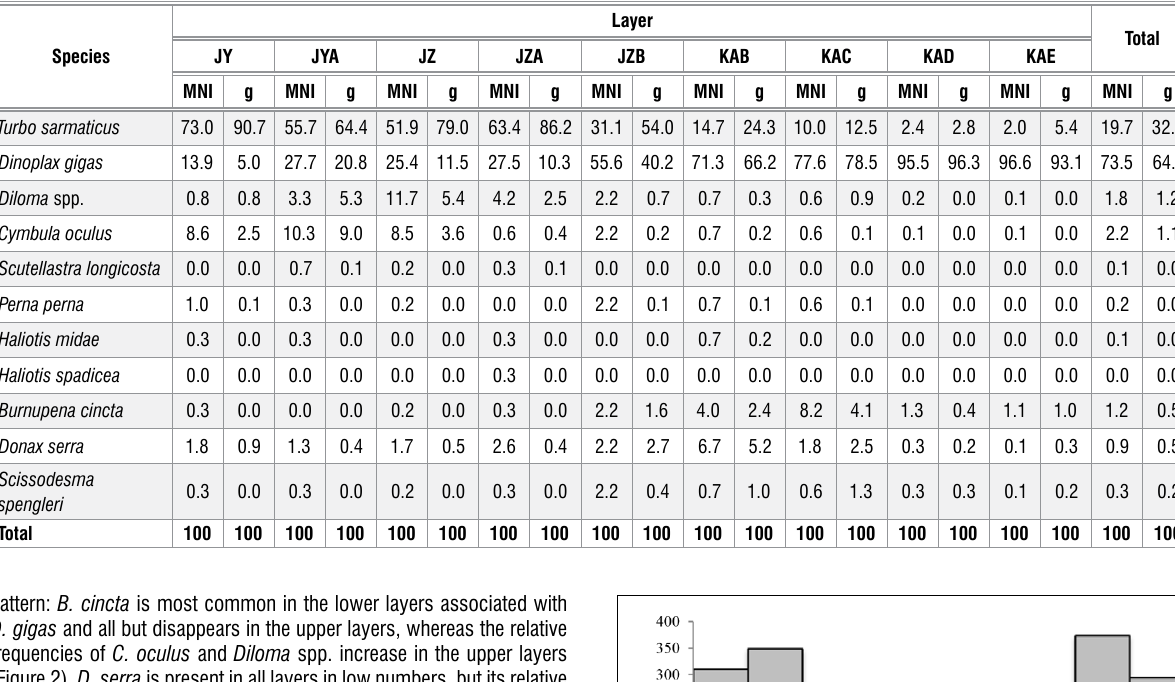
pattern: B. cincta is most common in the lower layers associated with D. gigas and all but disappears in the upper layers, whereas the relative frequencies of C. oculus and Diloma spp. increase in the upper layers (Figure 2). D. serra is present in all layers in low numbers, but its relative frequency is highest in the same layers where B. cincta is most common.